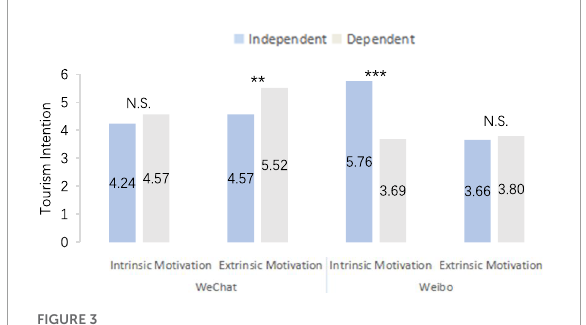
FIGURE3 The influence of potential tourists self-construction on tourism intention. ∗∗∗ p < 0.01, ∗∗ p < 0.05. N.S. = no